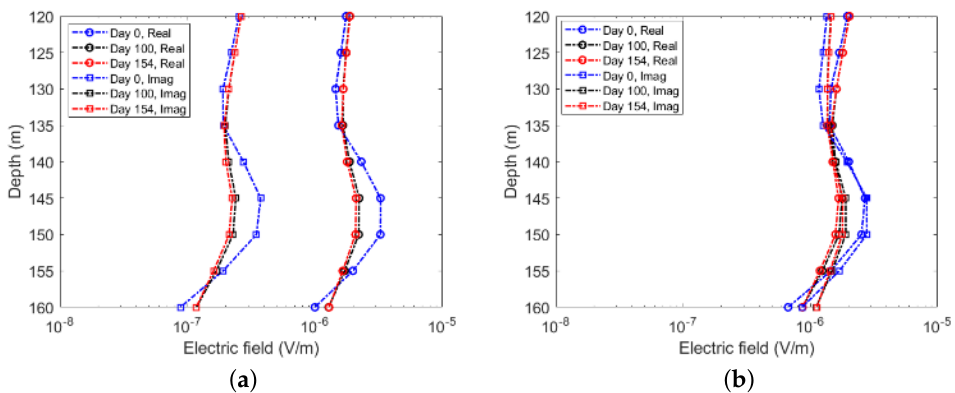
Figure 16. Electric fields from the HED source using the surface-to-borehole method at ( x , z ) = ( − 100 m, − 5 m) with two different Hz. ( a ) 10 Hz. ( b ) 100